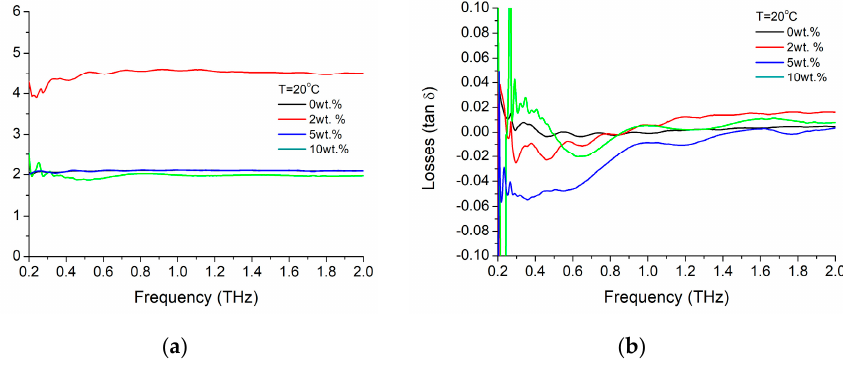
Figure 15. BTO-SBS film composite ( a ) dielectric constant ε′ and ( b ) losses variations with frequency at room temperature, for 2 wt%, 5 wt% and 10 wt%.